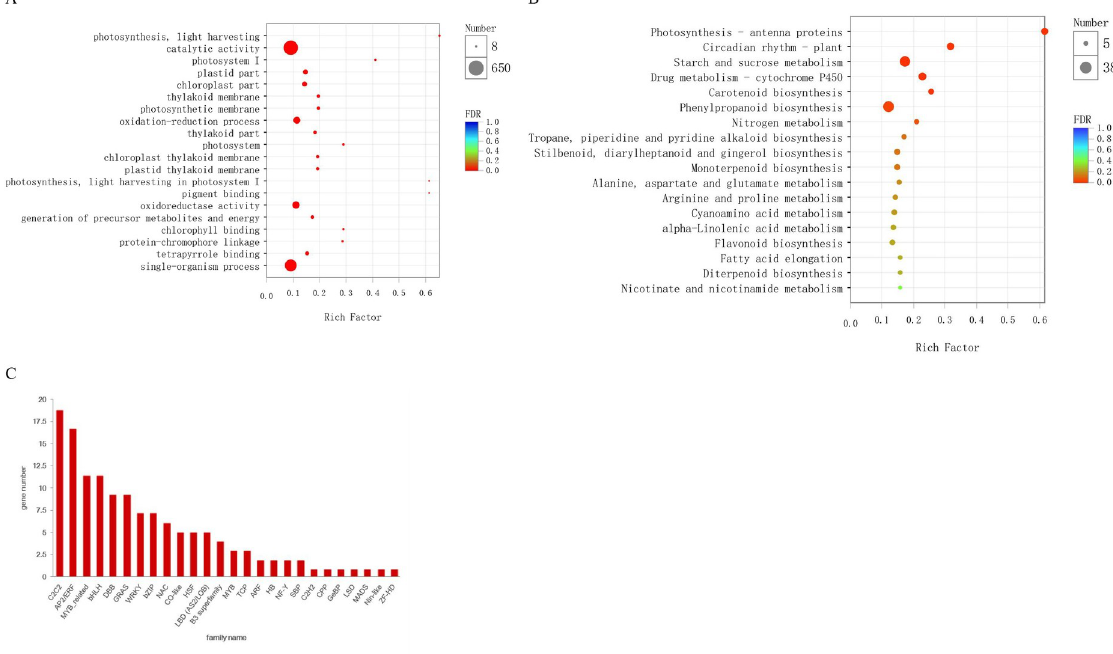
Fig 4. Annotation and pathway analyses of the identified DEGs. (A) GO enrichment analysis of common DEGs. (B) The scatter plot of enriched KEGG pathways of DEGs. (C) Number of genes from TF families in the common DEGs.